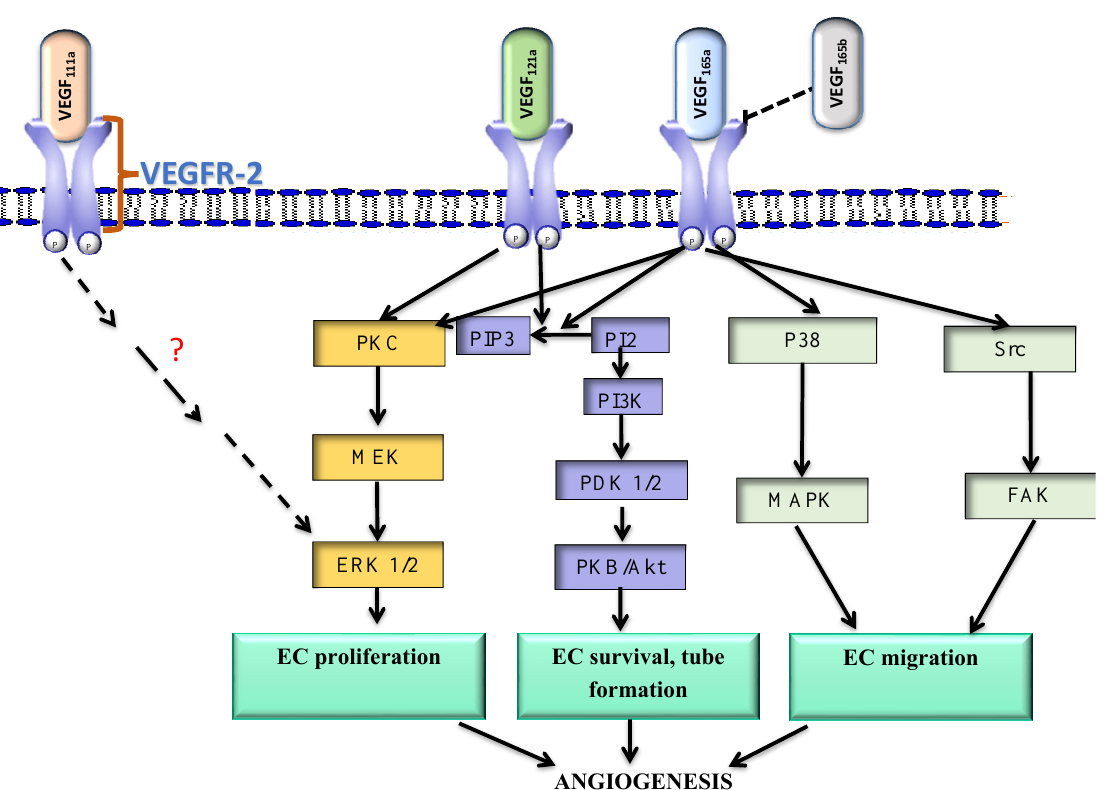
Figure 1. Signaling pathways activated by VEGF isoforms that promote angiogenesis. VEGF xxxb has an inhibitory effect on the VEGF xxxa -VEGFR-2 complex.